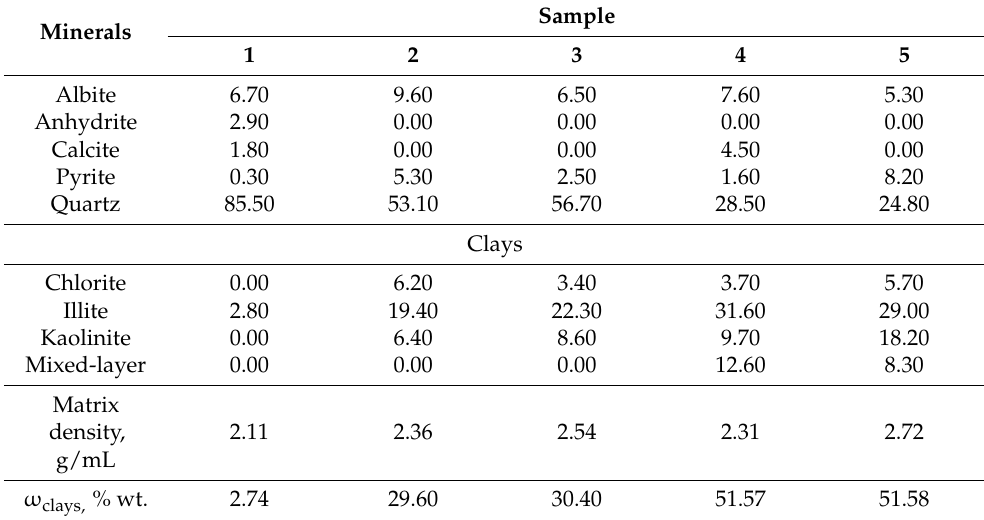
Table 2. Mineralogical composition of the studied rock samples defined with XRD method.